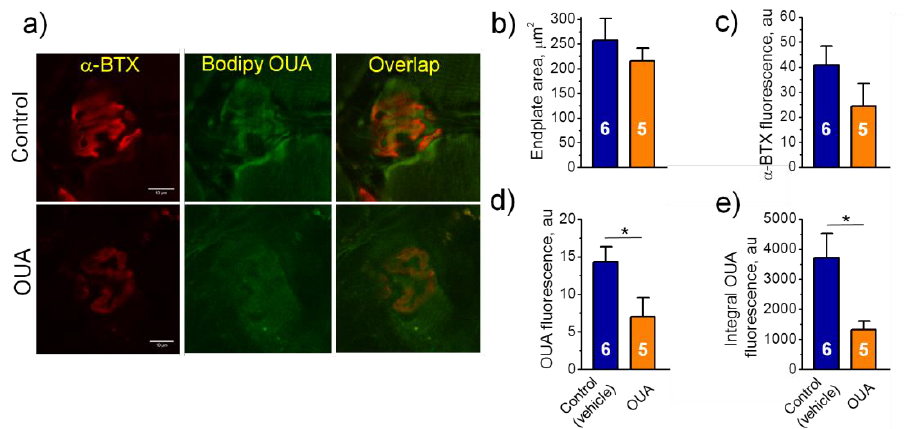
Figure 5. Characteristics of the α 2 Na,K-ATPase localization in the rat diaphragm muscles. ( a ) Representative images of endplates dual-labeled with α -BTX (nAChRs, red channel) and BODIPY-conjugated ouabain ( α 2 Na,K-ATPase, green channel). Overlap—orange. Scale bars—10 µ m. ( b , c ) Averaged area of endplates and fluorescence intensity (arbitrary units) from the nAChR staining, respectively. ( d , e ) Averaged fluorescence intensity and integral intensity over the entire area of the endplates from the α2 Na,K-ATPase staining (arbitrary units). Control and ouabain-treated (OUA) groups are represented by the rats, which received injections of vehicle (0.9% NaCl) or ouabain for 4 days, respectively. Each data point is a mean value measured in muscles from 5–6 rats, as indicated (21–19 endplates per group). One-way ANOVA. * p < 0.05—compared with the control (vehicle treated group).